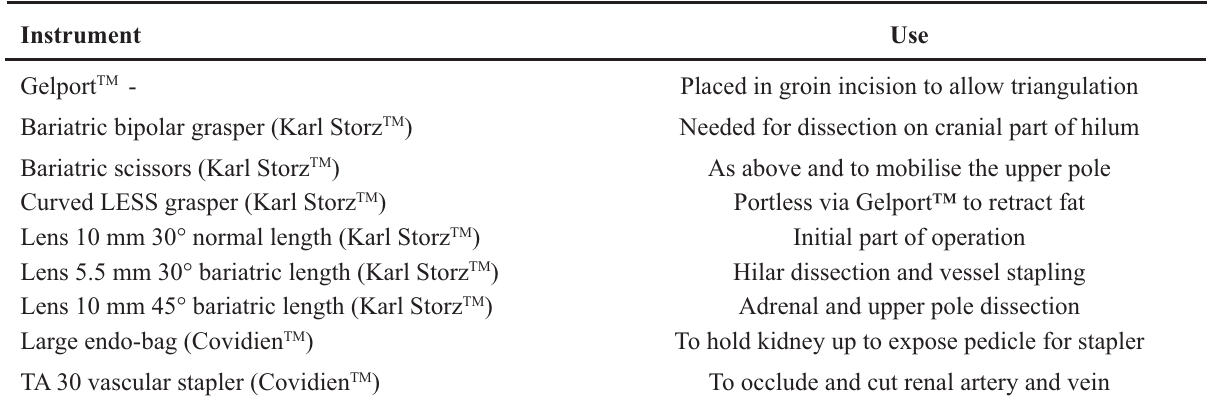
Table 1 – Instruments used for retroperitoneal LESS donor